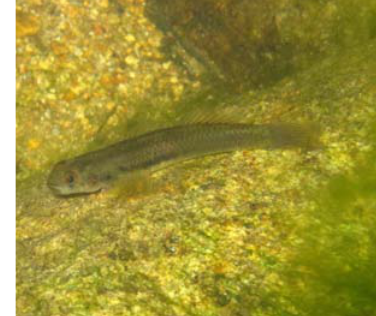
Image 17. Stiphodon percnopterygionus (male), orange colour form (Photo by W.W. Chau).